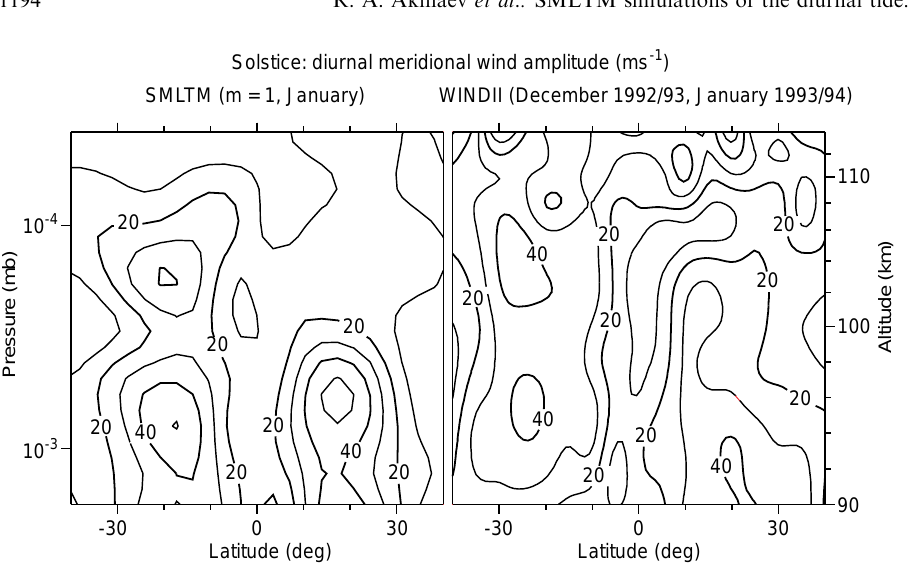
Fig. 4. Diurnal tidal amplitude for meridional wind (contour interval 10m s (cid:255) 1 ): SMLTM simulations ( m (cid:136) 1) for January ( left panel ); WINDII diurnal tidal amplitude (McLandress et al ., 1996) for De- cember 1992/93, and January 1993/ 94 ( right panel )